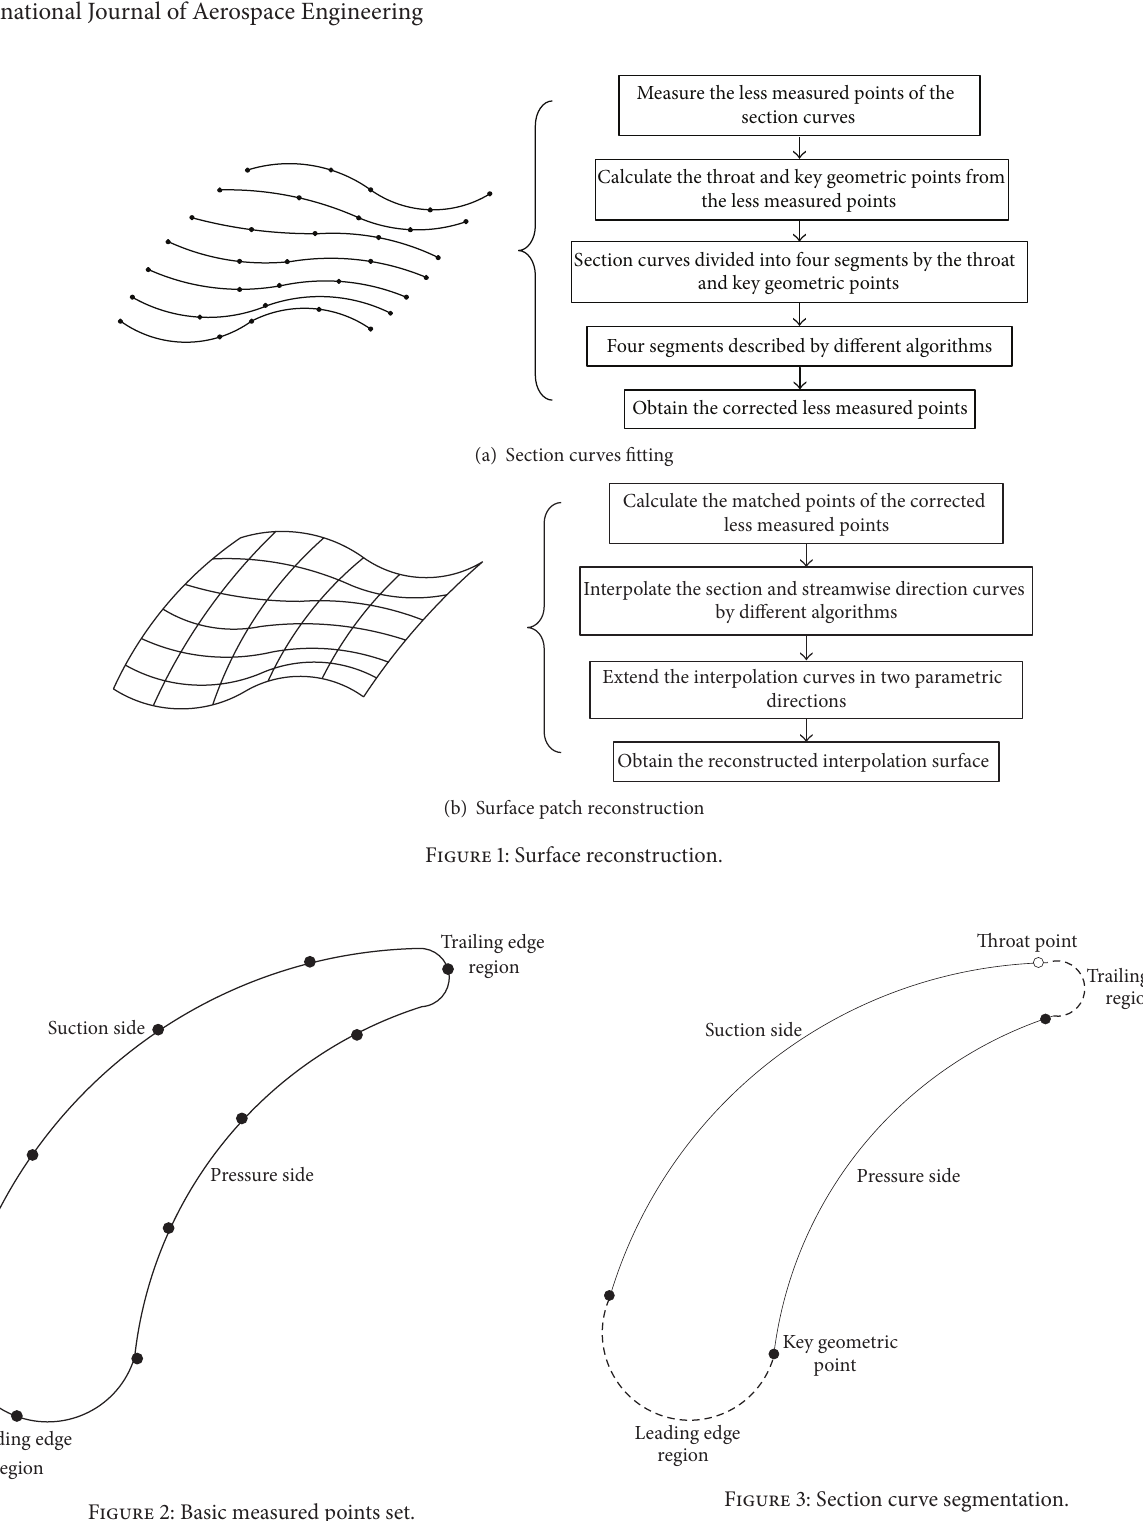
Figure 2: Basic measured points set.